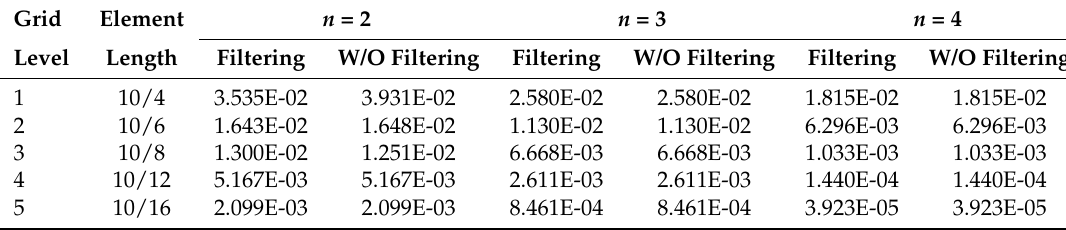
Table 2. L 2 error of density on structured grids with quadrilateral